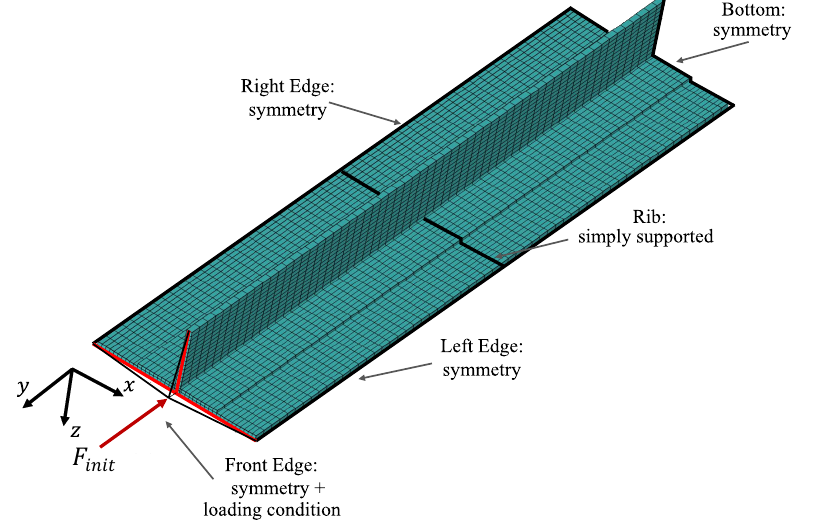
Figure 3. Double half-bay symmetric FE model for the representative unit cell. Force F unit represents the unitary compressive load applied for the first linear buckling analysis.